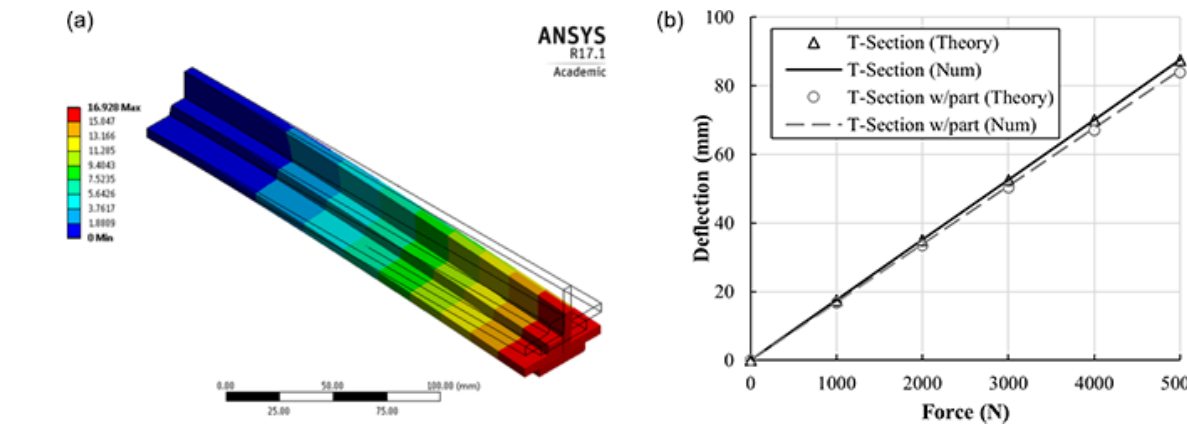
Figure 3. Numerical analysis of a cantilever composite T-section with LEP bonded to the underside, showing (a) the deformation (mm) for an end loading of 1000N and (b) a comparison of the maximum deformation (mm) with the theoretical